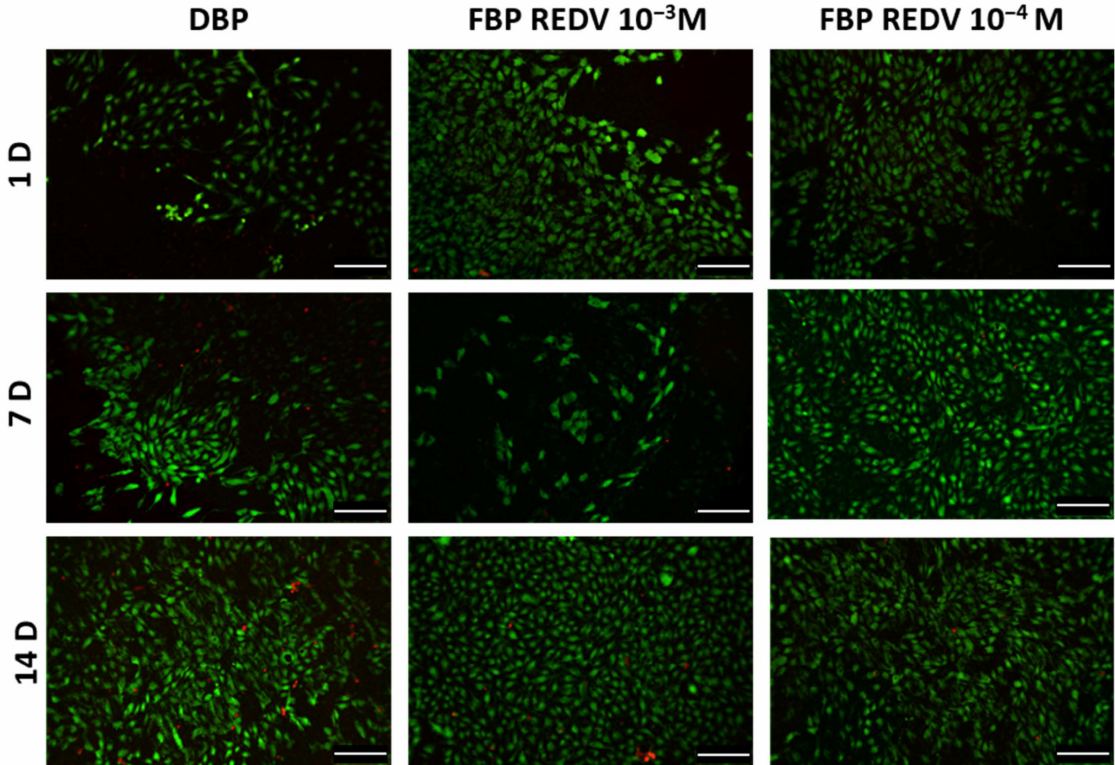
Figure 7. Live/dead staining on seeded samples of DBP and functionalized tissues (columns) analyzed at days 1, 7, and 14 (rows). Scale bar = 100 µ m. A quantification of the percentage of viable cells (mean ± standard deviation) for each experimental condition is reported in Table